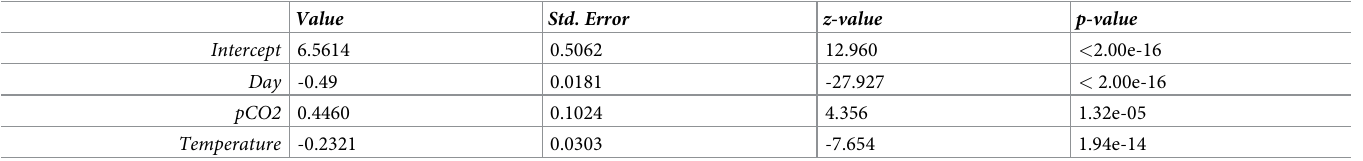
Table 2. Generalized linear model results for Y:E.